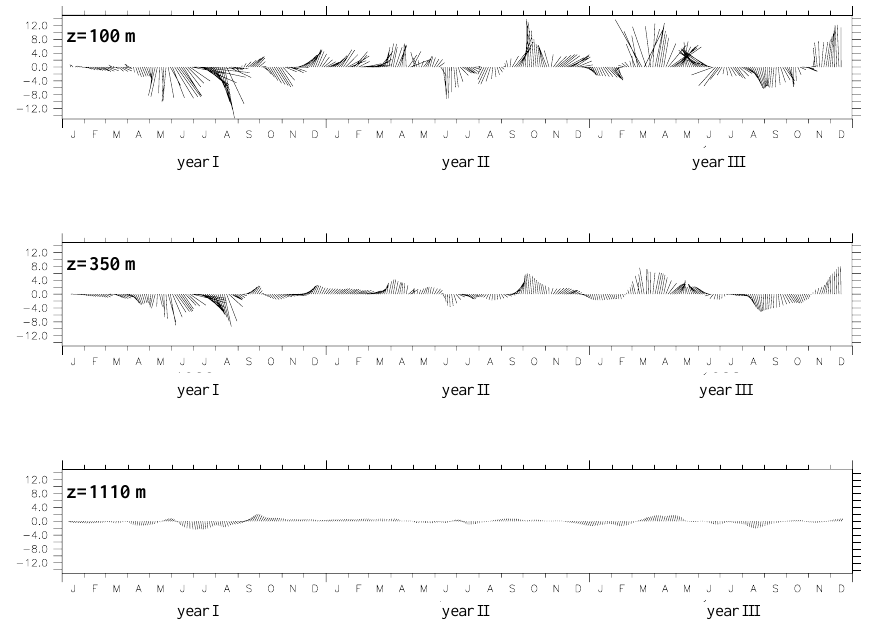
Fig. 5. Stick-vector plot at point A (8.6 ◦ E 43 ◦ N; see Fig. 6a) in the Ligurian Sea for three depths: 100m, 350m, 1110m.